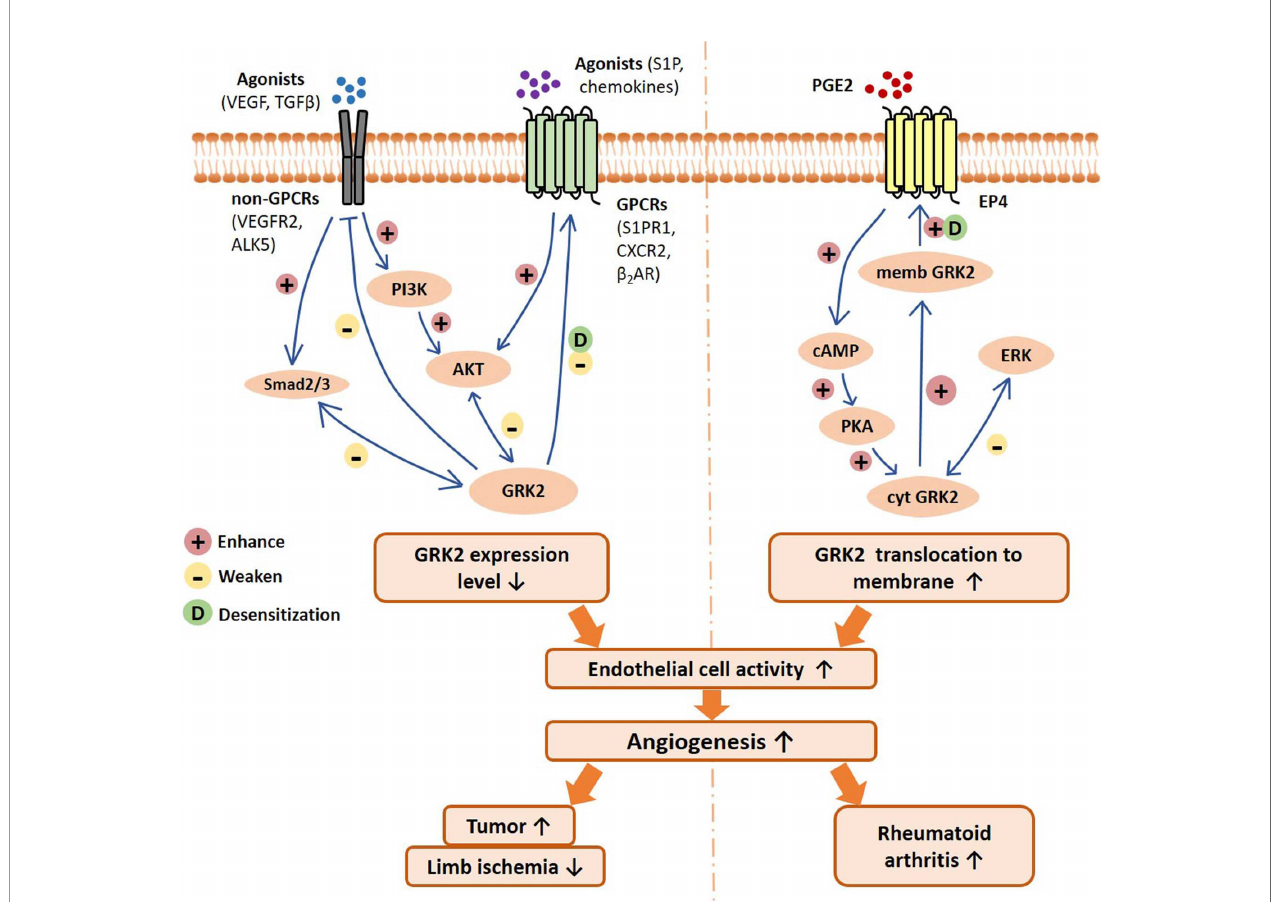
FIGURE 1 | Schematic of GRK2 signaling pathways regulating endothelial cell activity, angiogenesis, and related disease progression. On the one hand, GPCRs and non-GPCRs binding with agonists can activate Smad2/3 signal and PI3K/AKT signaling pathway, resulting in downregulation of GRK2 expression level. Reduced GRK2 expression level reduces GPCR desensitization and the inhibition of non-GPCRs. On the other hand, PGE2 activates the EP4/AC/cAMP/PKA pathway, which mediates GRK2 translocation to the cell membrane, resulting in the reduction of ERK inhibition. In different disease conditions, the decreased GRK2 expression or the increased GRK2 translocation may improve the activity of endothelial cells, and thus promote angiogenesis and disease progression. VEGF, vascular endothelial growth factor; TGF b , transforming growth factor b ; VEGFR2, vascular endothelial growth factor receptor 2; ALK5, TGF- b type I receptor ALK5 (activin receptor-like kinase 5); S1P, sphingosine 1 phosphate; S1PR1, sphingosine 1 phosphate receptor 1; b 2 AR, b 2 -adrenergic receptor; CXCR2, chemokine (C-X-C motif) receptor 2; PGE2, prostaglandin E2; EP4, prostaglandin E2 receptor 4; PI3K, phosphoinositide 3-kinase; AKT, protein kinase B; cAMP, cyclic adenosine monophosphate; PKA, Protein Kinase A; ERK, extracellular regulated protein kinases; memb, membrane; cyt,